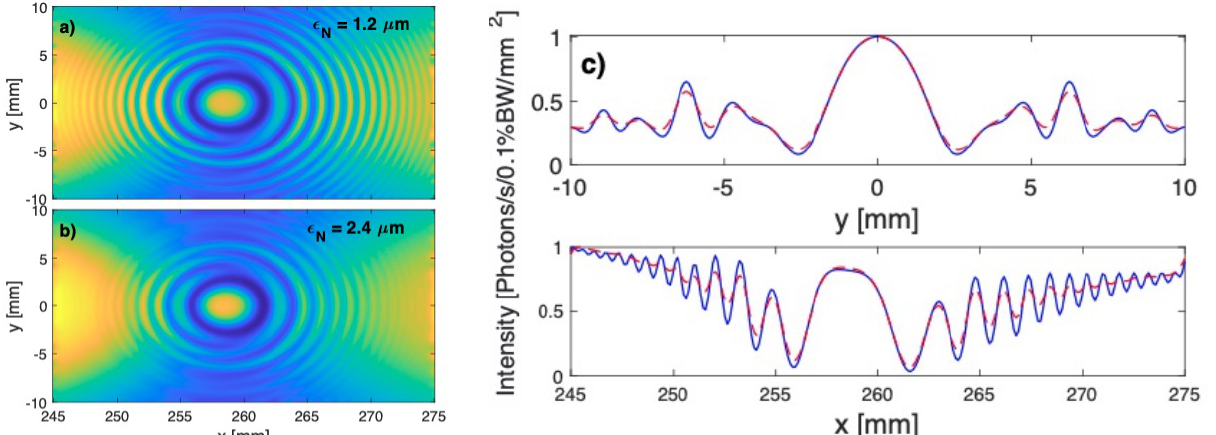
Figure 5. ( a , b ) Examples of edge radiation interference patterns for beams of different emittance at 1 nC charge, 135 MeV beam energy with corresponding lineouts. ( c ) The interference pattern will be used as input to a Convolutional Neural Network (CNN) based image analysis, which will determine the beam emittance from the two-dimensional (2D) images in